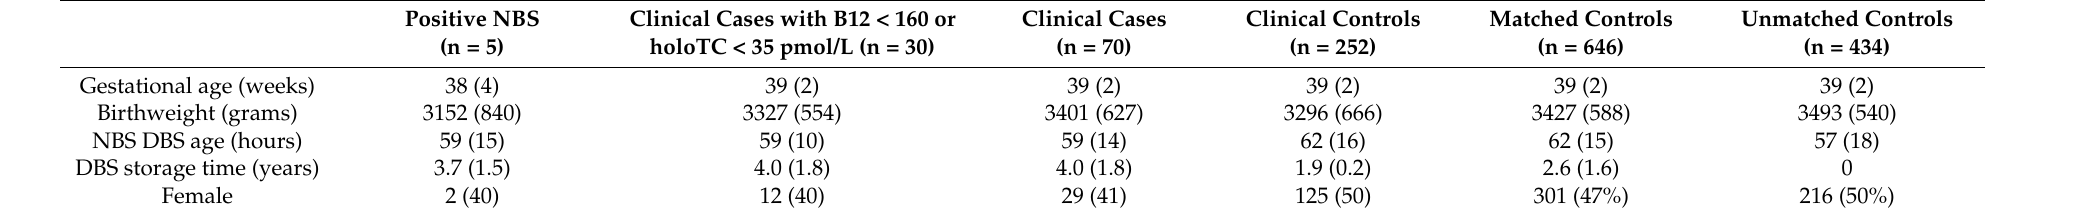
Table 1. Descriptive characteristics of cases and controls, mean (SD) and n (%).